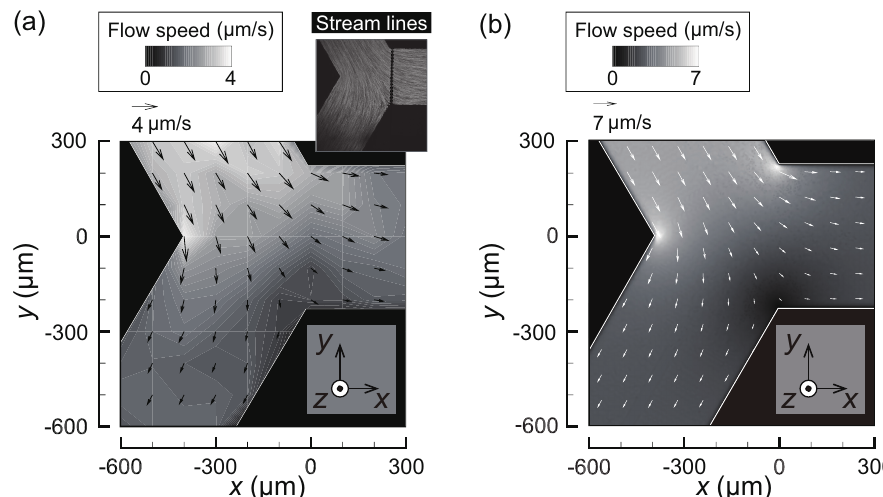
Figure 2. Flow field at the test section without Joule heating for ∆ P = 1 × 10 − 2 Pa. The inlet flow is equally separated into two outlet flows. ( a ) Experimental result obtained by the particle image velocimetry (PIV) analysis. ( b ) Numerical result at z = h /2 obtained by the simulation using a finite element